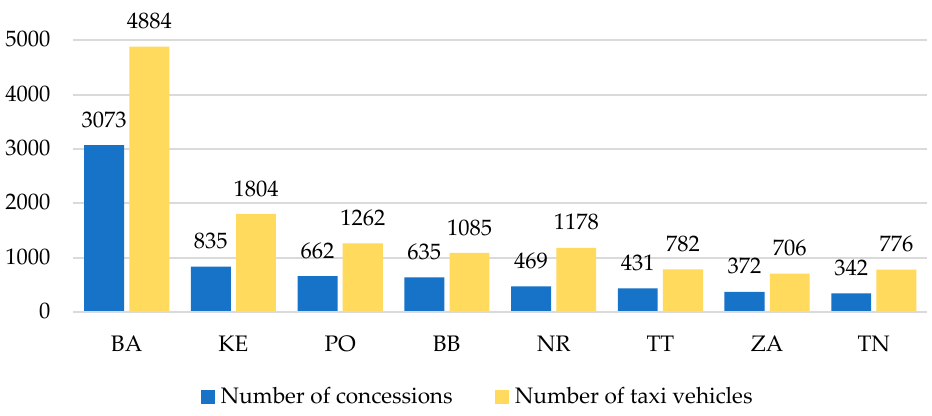
Figure 1. Current state of taxi business in Slovakia (May 2021). Abbreviations of regions: Bratislava (BA), Košice (KE), Prešov (PO), Banská Bystrica (BB), Nitra (NR), Trnava (TT), Žilina (ZA) and Tren č ín (TN).